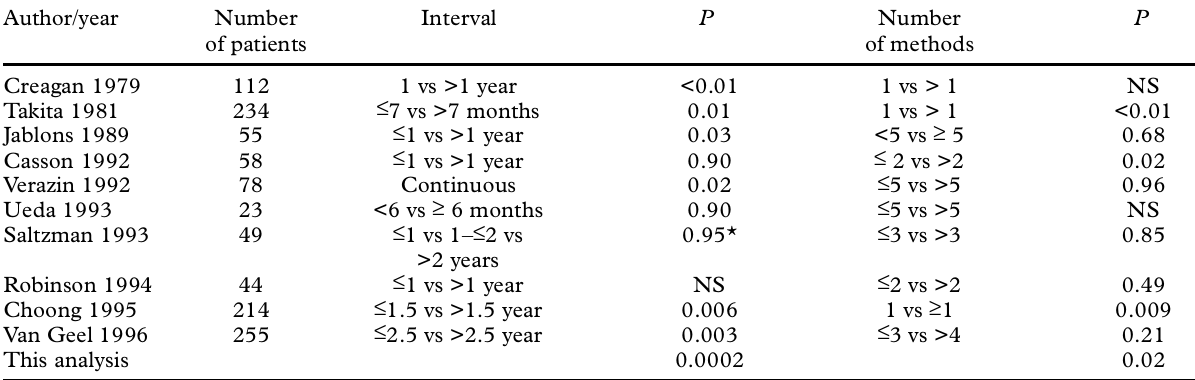
Table 1. Analysis of 10 related studies on prognostic factors by combining p